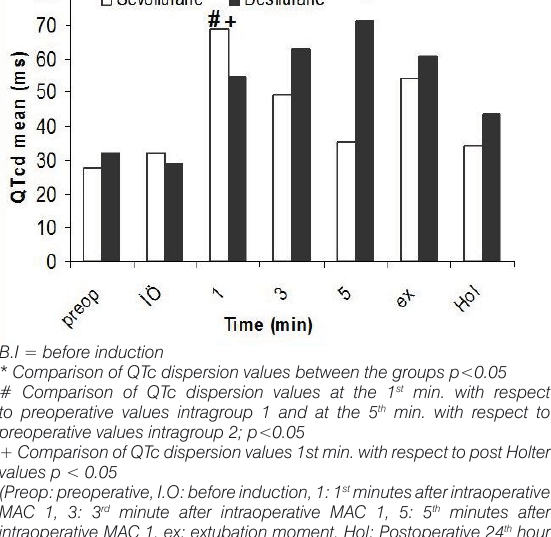
Figure 3. Comparison of mean QTc dispersion between the groups (Mean ± SD).